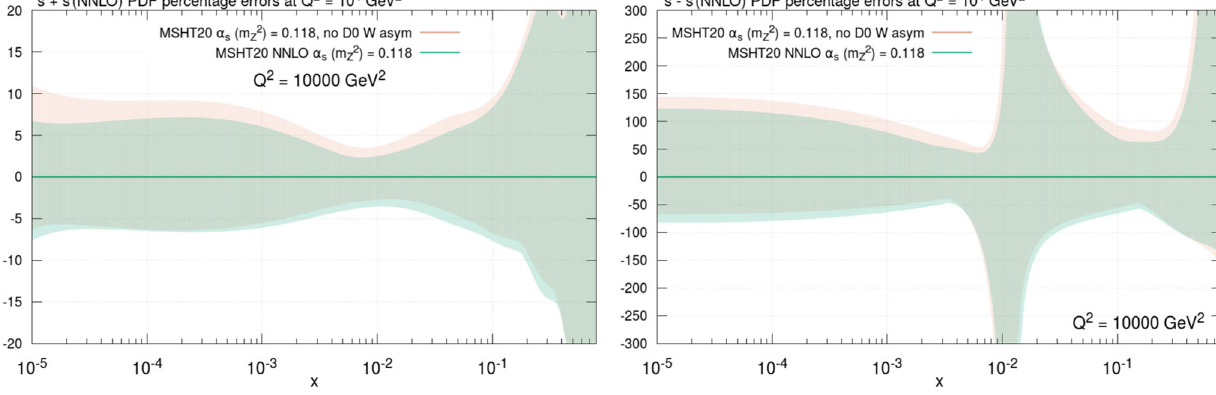
Fig. 64 (Left) s + ¯ s and (right) s − ¯ s PDF percentage errors at Q 2 = 10 4 GeV 2 at NNLO in both the MSHT20 default fit and the same with the removal of the DØ W asymmetry data, and without fitting the electron